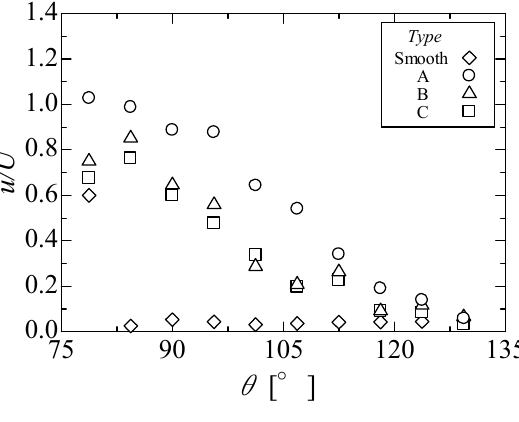
Fig. 7 Velocity distributions ( r/d =0.5)